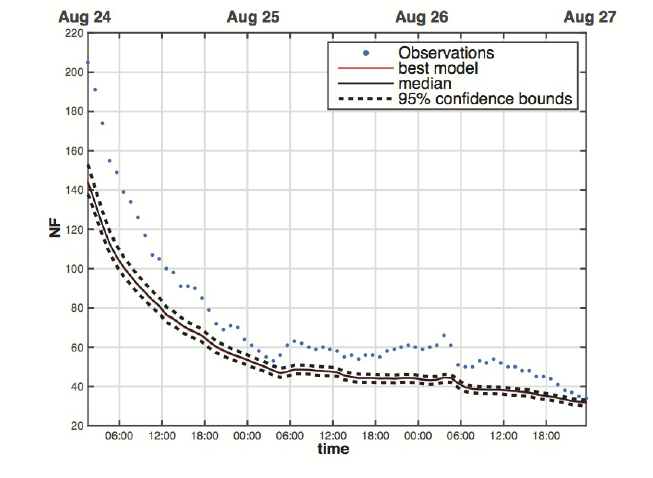
Figure 4: Parameters sensitivity analysis for the ETAS model. The plot compares observations and forecasts for M F = 2.5 and for the first 3 days of the sequence (Aug